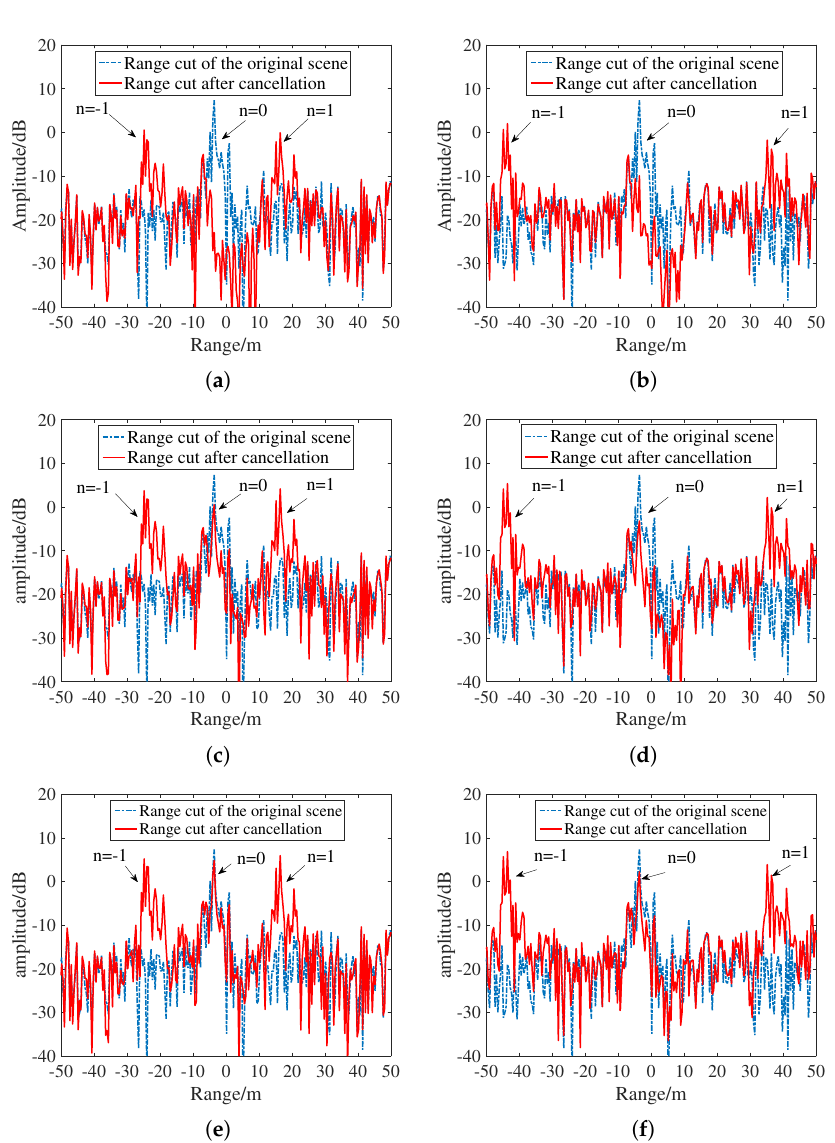
Figure 9. Range cut at azimuth unit 20 m. ( a ) Ideal amplitude match ( f s = 20 MHz). ( b ) Ideal amplitude match ( f s = 40 MHz). ( c ) Amplitude mismatch ( γ = 50%, f s = 20 MHz). ( d ) Amplitude mismatch ( γ = 50%, f s = 40 MHz). ( e ) Amplitude mismatch ( γ = 80%, f s = 20 MHz). ( f ) Amplitude mismatch ( γ = 80%, f s = 40